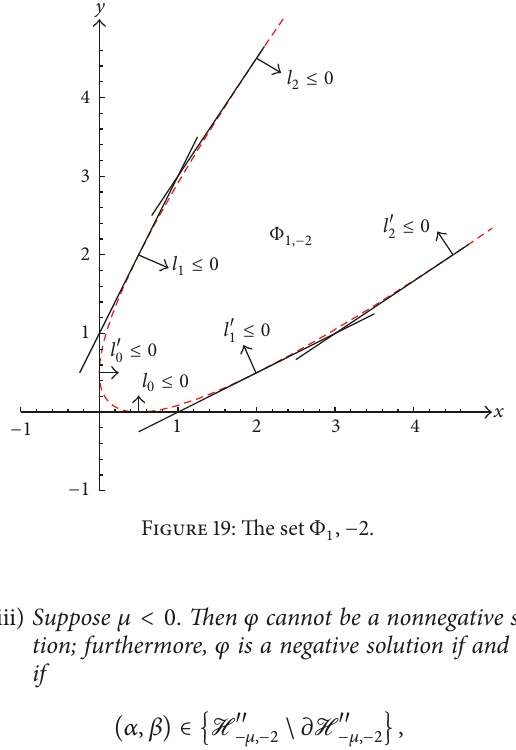
Figure 19: The set Φ 1 , −